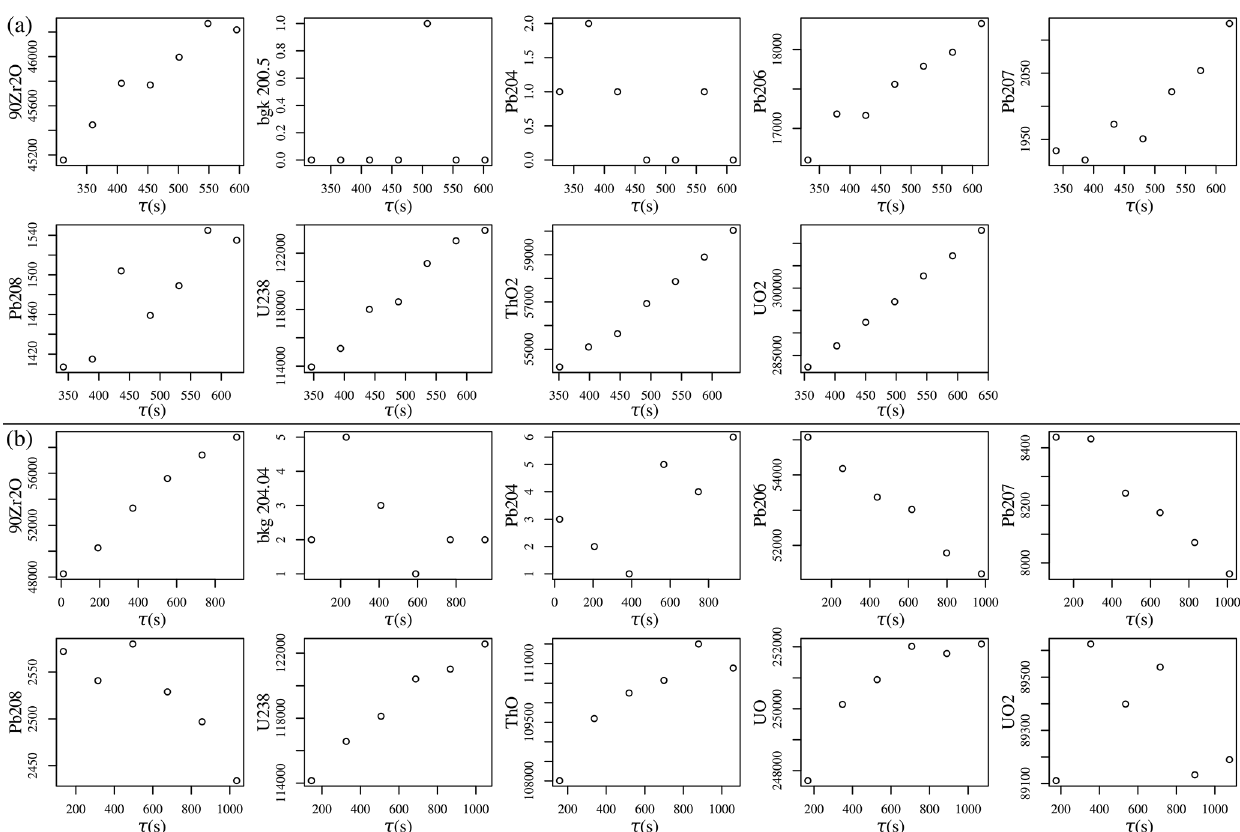
Figure 3. Time-resolved signals (counts) of (a) Temora2 (spot Tem@6 ) analysed by a Cameca 1280HR instrument at IGG-CAS Beijing; (b) M127 zircon (spot M127.1.2 ) analysed by a SHRIMP-II instrument at Geoscience Australia. Table 2. Uncertainty budget of the four Temora2 zircon analyses highlighted in Fig. 8. The first two data columns show the calibrated 206 Pb / 238 U log ratios and their standard errors ignoring the uncertainty of the calibration fit (i.e. using internal uncertainties only). The third column shows the total error including the external uncertainty associated with the calibration fit. The upper triangular matrix shown in the remaining three columns contains the (total) error correlations of the four aliquots. ln[ 206 Pb / 238 U] int. unc. tot. unc. r [∗ ,b ] r [∗ ,c ] r [∗ ,d ] (%)